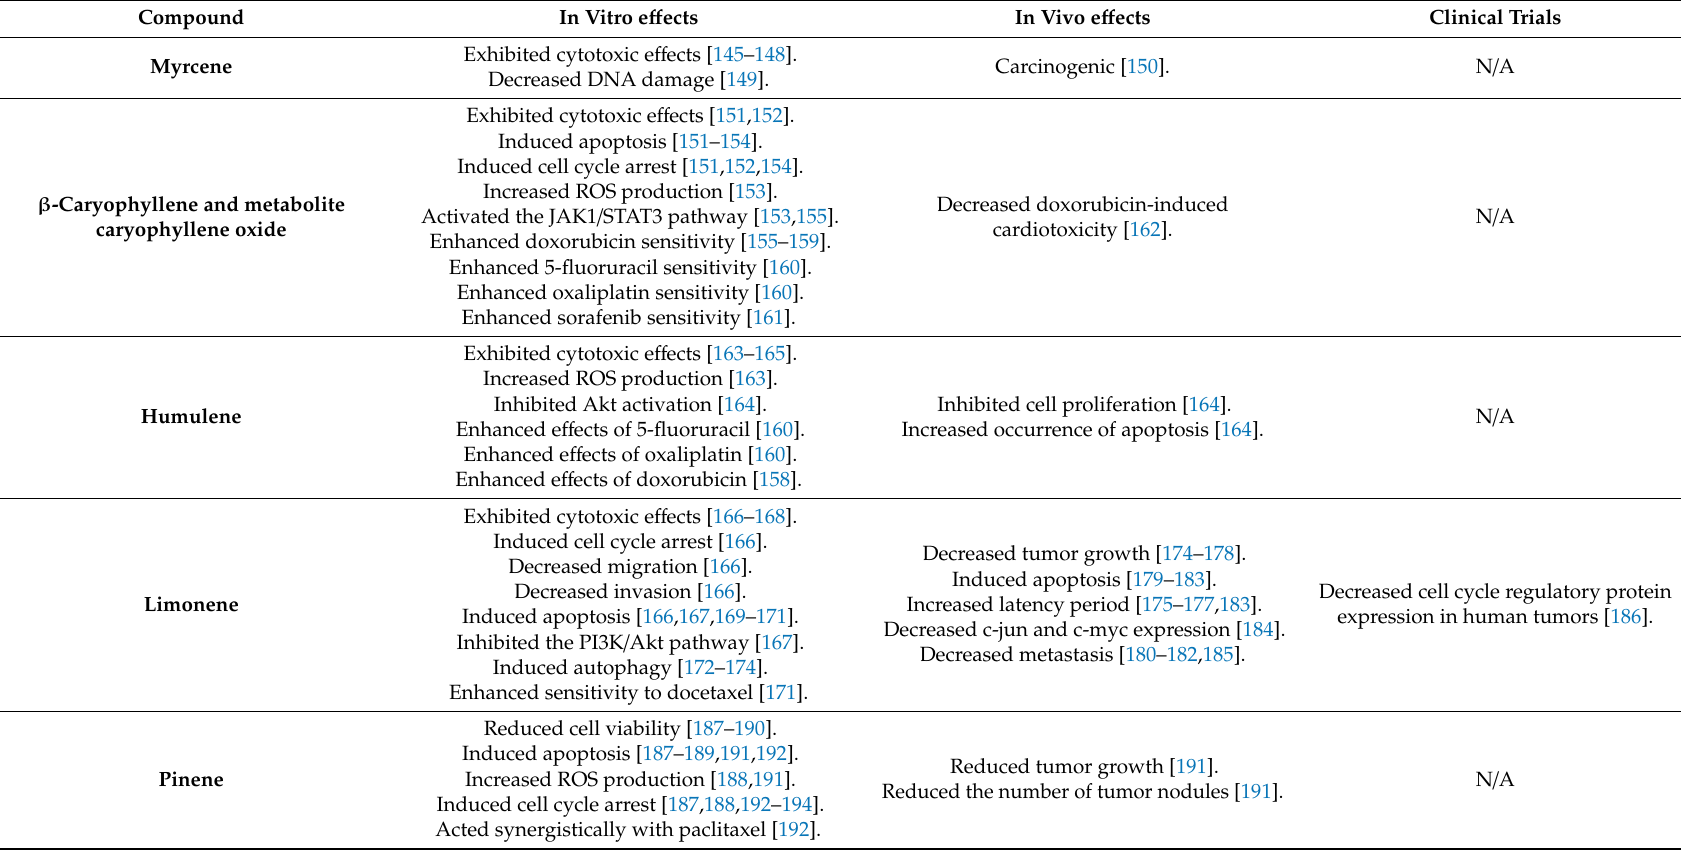
Table 2. Anti-Cancer E ff ects of Terpenes Present in